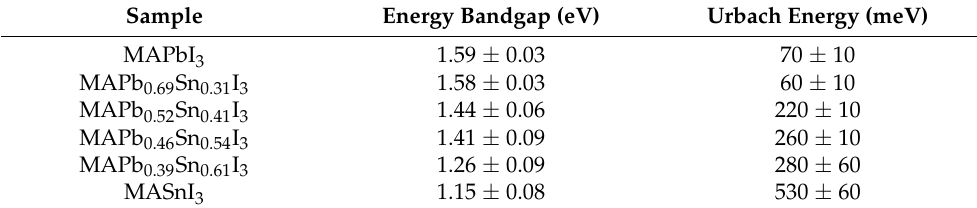
Table 3. Energy Bandgap and Urbach energy of binary metal